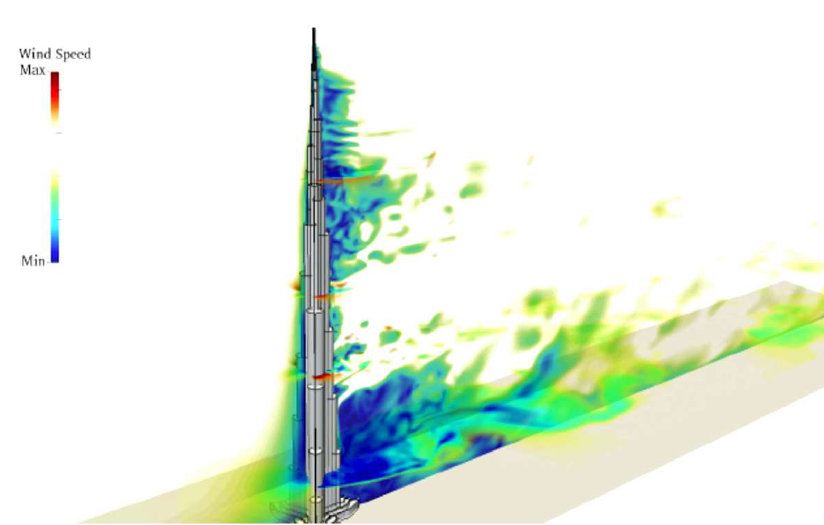
Figure 10. CFD simulation using Sim-Scale for Burj Khalifa showing effective building configura- tions in mitigating wind effects. Source: